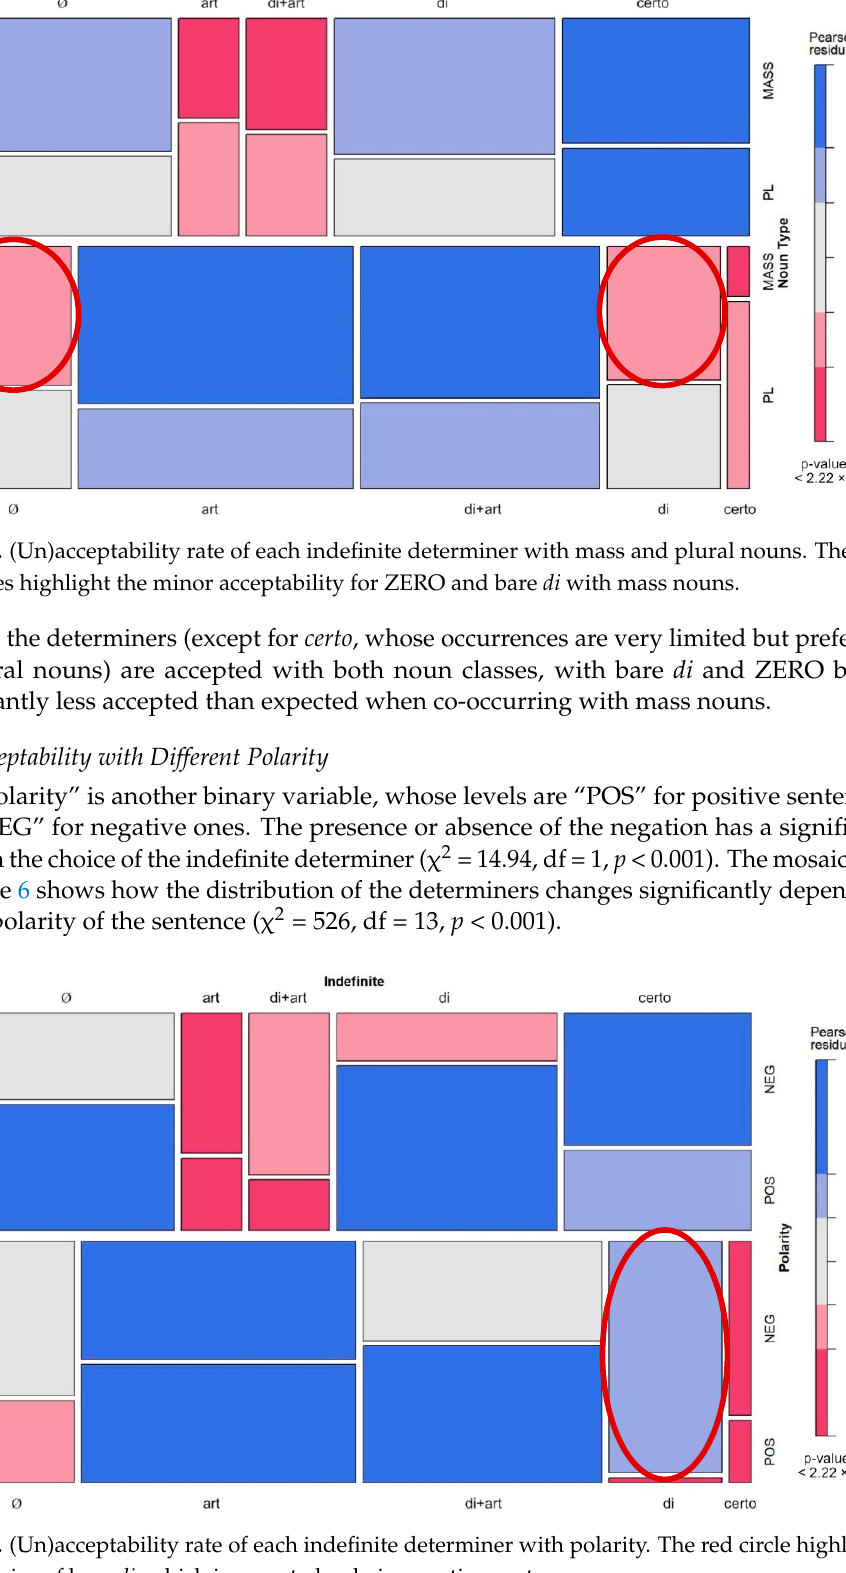
Figure 6. (Un)acceptability rate of each indefinite determiner with polarity. The red circle highlights the behavior of bare di , which is accepted only in negative